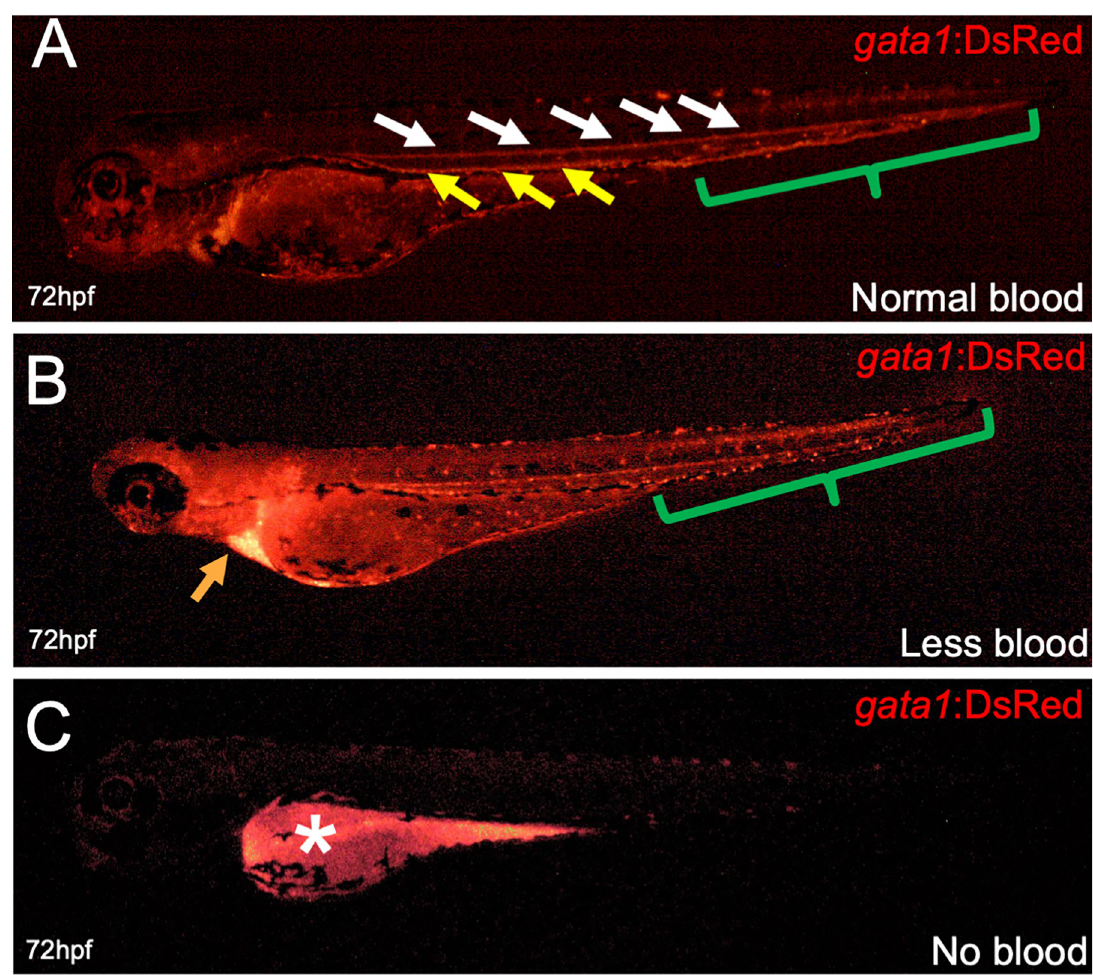
Fig 2. Representative images of red blood cells after PCP addition. gata1 :DsRed embryos were treated with 25 μ g/L PCP at 48 hpf and fluorescence was analyzed 24 hours later at 72 hpf. (A) “Normal” blood development was characterized by continuous circulation and fluorescence in the dorsal aorta (white arrows), cardinal vein (yellow arrows), and the caudal hematopoietic tissue (green bracket). (B) “Less blood” was characterized by a non-continuous stream of fluorescent cells and visibly reduced blood circulation and pooling of blood in the Ducts of Cuvier (orange arrow). (C) “No blood” was characterized by the absence of fluorescent blood cells in the fish and no observable circulation. White star denotes autofluorescence in the yolk